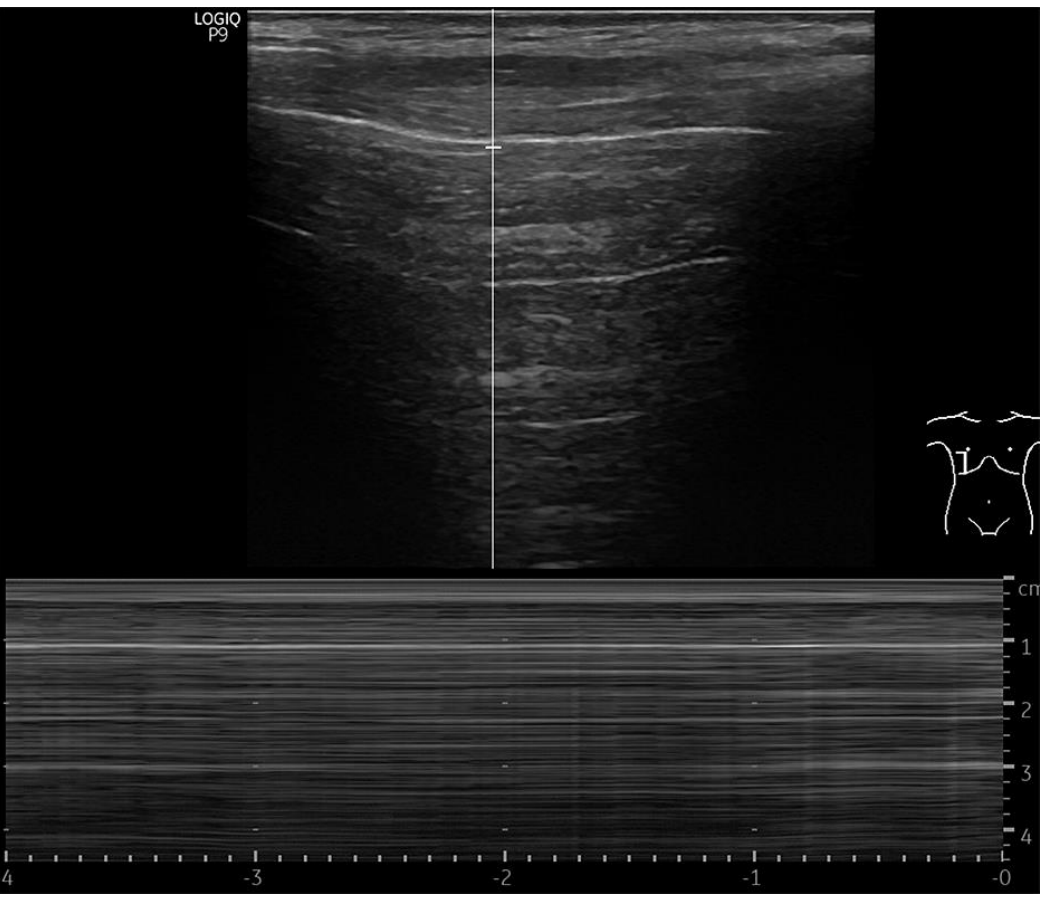
Figure 1. Stratosphere sign in M − mode caused by absence of lung sliding in pleural line during breathing, suggesting pneumothorax.